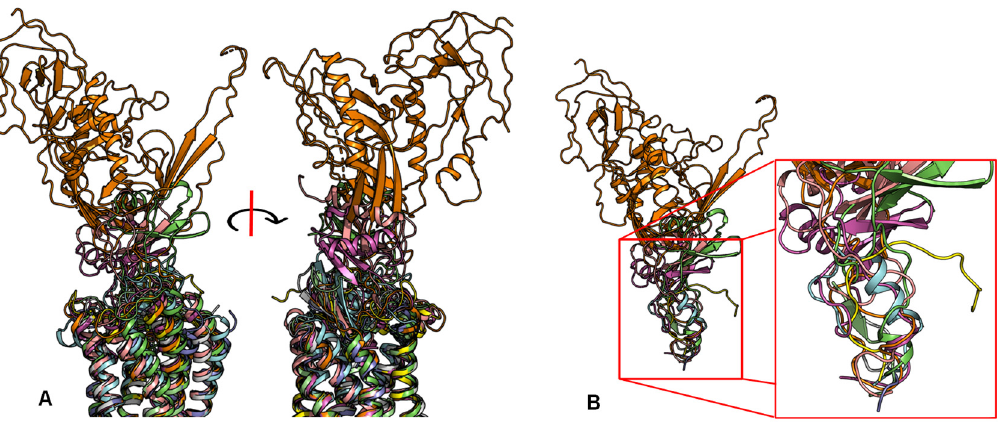
Figure 2. Despite the diversity in the peptide engagement, their overlapping region at the core of their binding pocket suggests common ligand-GPCR interactions. ( A ) Superimposition of the nine peptides/class A GPCR complexes. ( B ) Overlay of all peptide ligands and zoom-in of the peptide region at the cores of GPCRs.